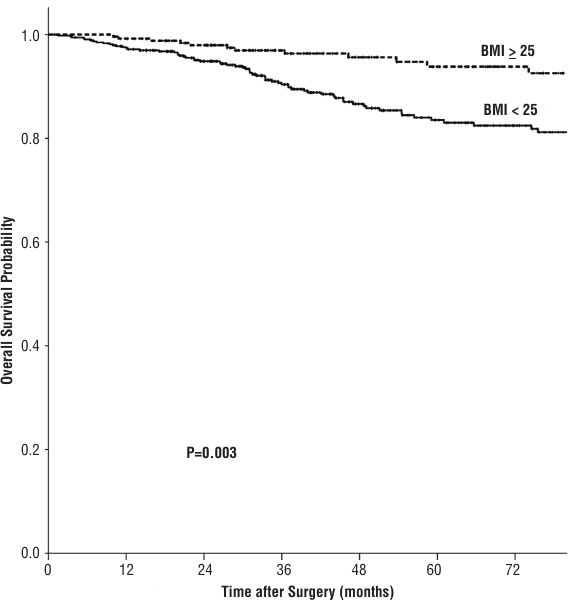
Figure 1 - Overall survival by BMI group among Chinese patients with RCC.